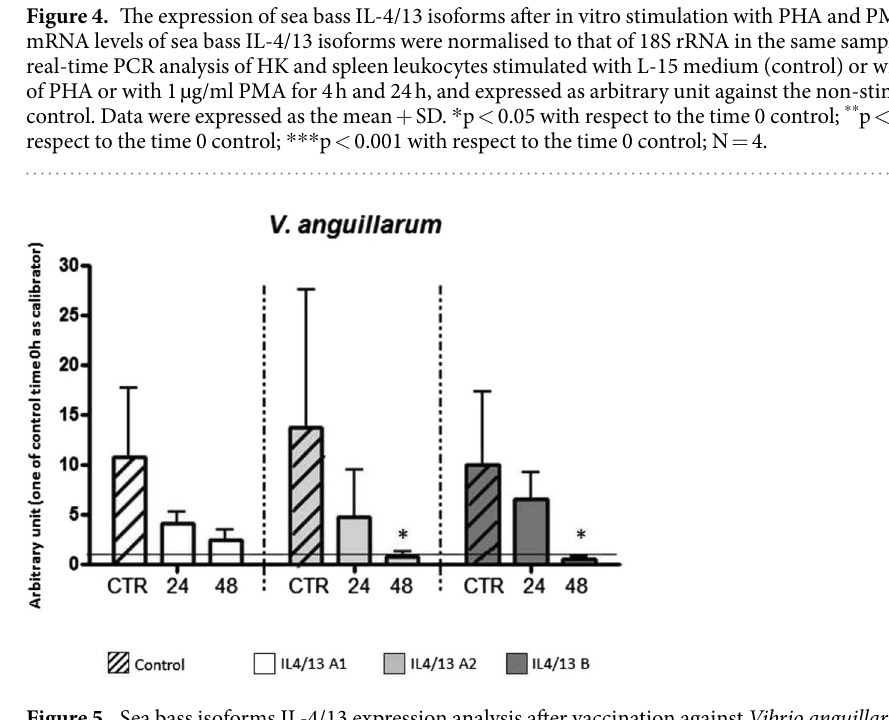
Figure 5. Sea bass isoforms IL-4/13 expression analysis after vaccination against Vibrio anguillarum . Sea bass IL-4/13 isoforms mRNA levels were expressed as a ratio relative to rRNA 18S in the same samples after real-time PCR analysis of HK leukocytes of four fish vaccinated against Vibrio anguillarum . Data were expressed as the mean + SD. * p < 0.05 with respect to the time 0